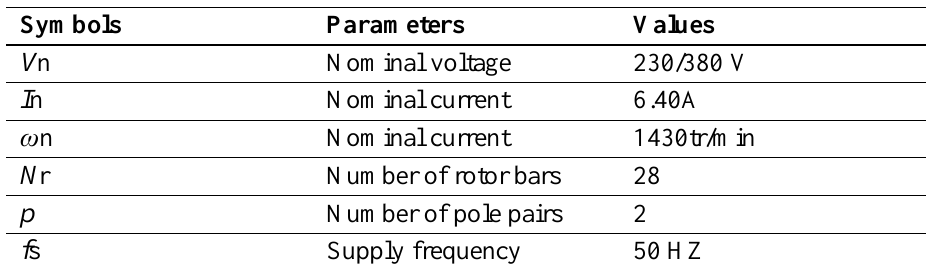
Table 1. Motor Parameters